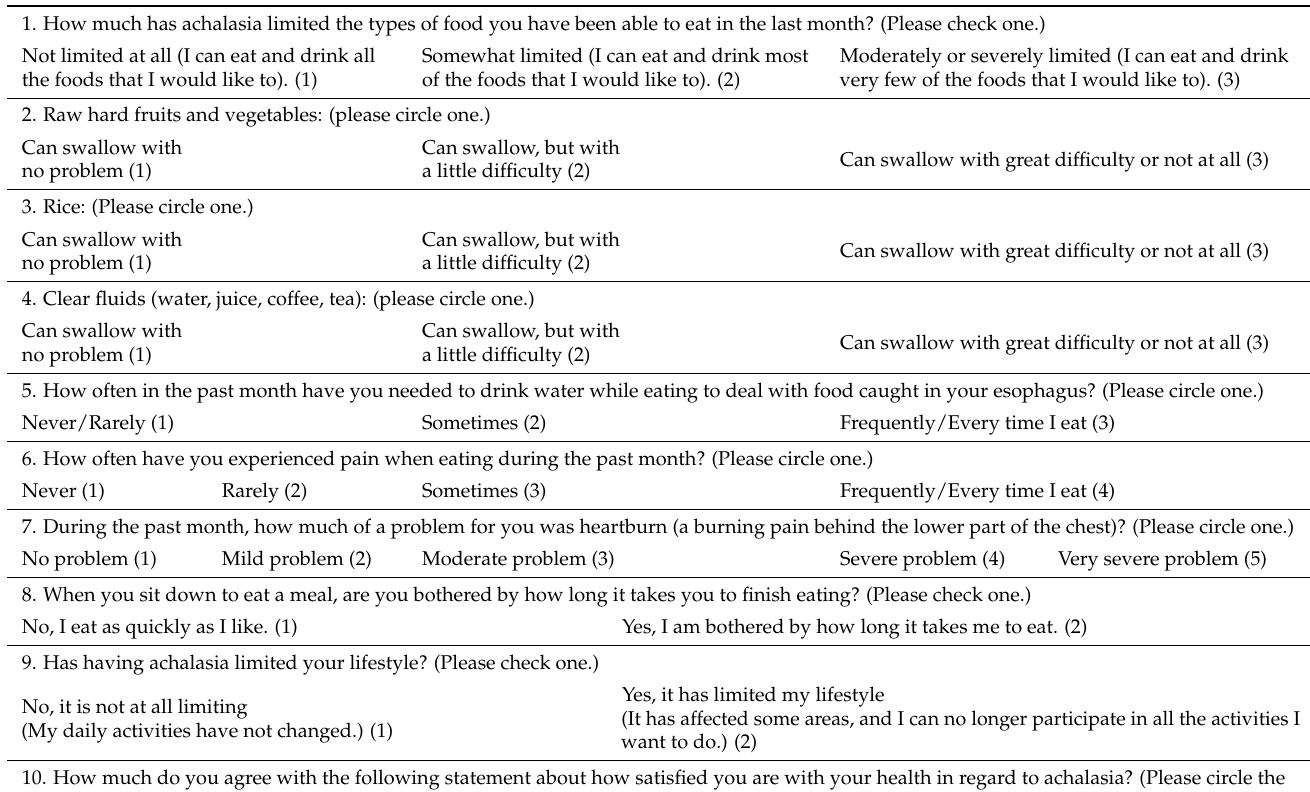
Table 1. Quality of life assessment according to Urbach scale questionaries [13].